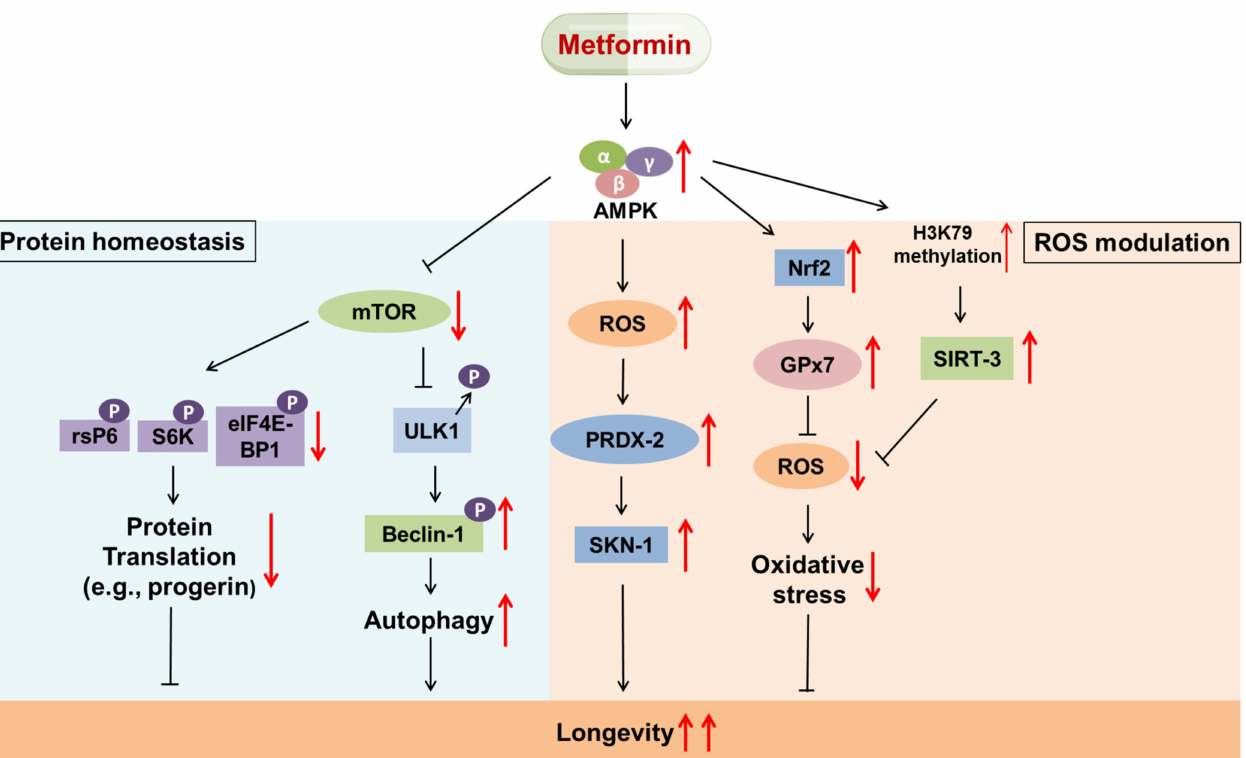
Figure 1. The antiaging effect of metformin. (Left panel) Metformin exerts an antiaging effect by modulating protein homeostasis. Metformin can suppress protein translation (e.g., progerin) and enhance autophagy to extend longevity via AMPK-induced inhibition of mTOR activity. It impedes the translation of aging-related proteins such as progerin through a decrease in the phosphorylation of ribosomal protein S6 (rsP6), S6 kinase (S6K) and eIF4E-binding protein 1 (eIF4E-BP1). In addition, metformin initiates the dephosphorylation of ULK1 and further results in the phosphorylation of Beclin-1, which triggers autophagy. (Right panel) Metformin exerts an antiaging effect by modulating ROS. ROS serve as a double-edged sword in the modulation of the aging process. On the one hand, AMPK-induced accumulation of ROS facilitates longevity via the PRDX-2/SKN-1 axis. On the other hand, AMPK alleviates ROS accumulation and increases longevity through the Nrf2/GPx7 axis of